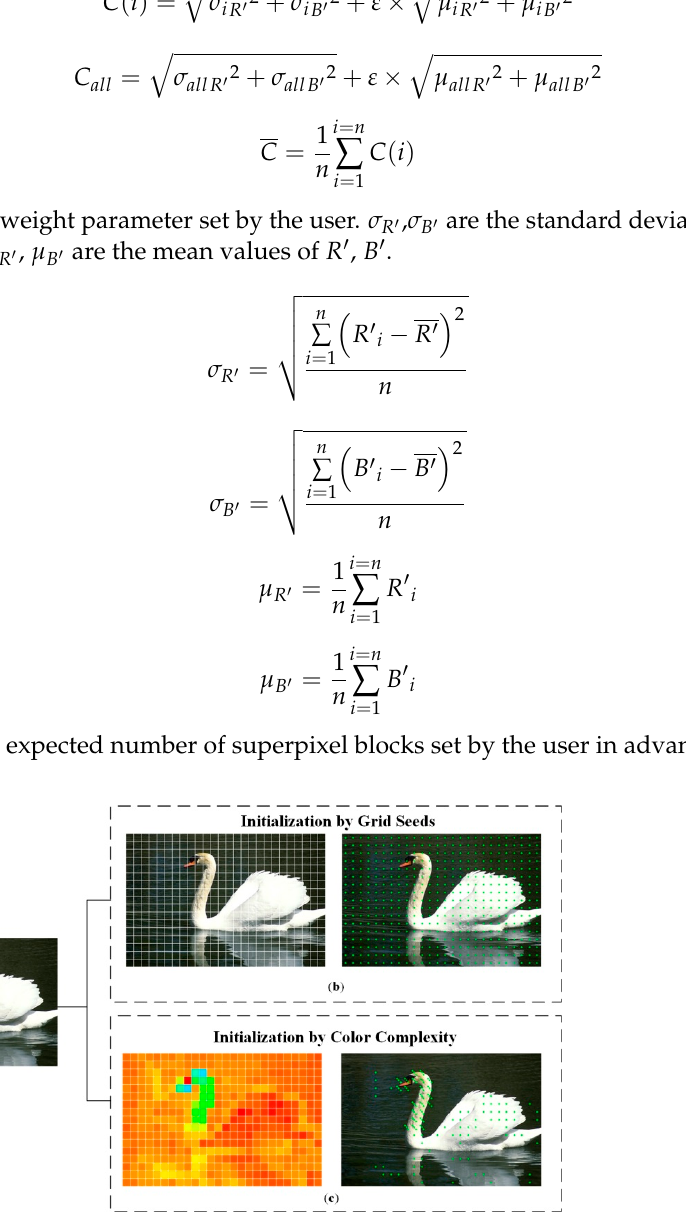
Figure 4. Two different seed initialization methods. ( a ) Input image; ( b ) Grid uniform seed initialization; ( c ) Seed initialization based on content adaptation. The color grid in Figure ( c ) is a diagram of content complexity. Different colors represent different levels of complexity.